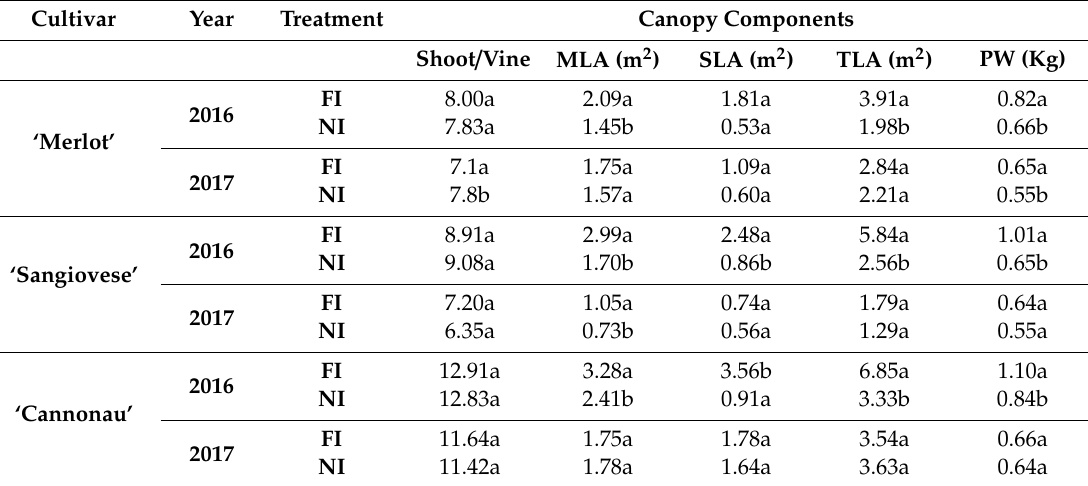
Table 2. Main components of canopy in ‘Merlot’, ‘Sangiovese’ and ‘Cannonau’ vines subjected to full irrigation (FI) or no irrigation (NI). MLA = main leaf area; SLA = secondary leaf area; TLA = total leaf area; PW = pruning weight. Means within column / component followed by di ff erent letters were significantly di ff erent at P ≤ 0.05 using